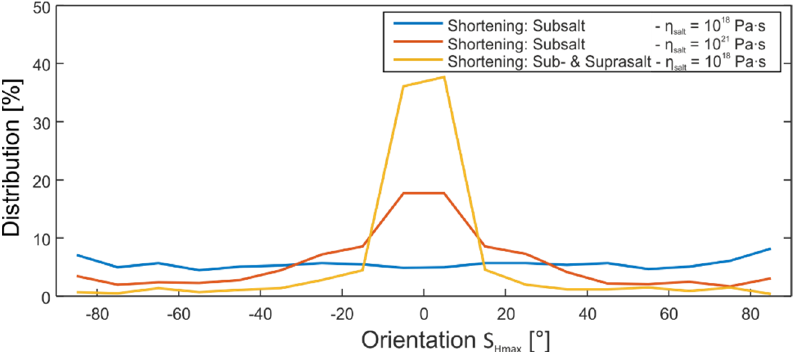
Figure 11 . Frequency distribution of S Hmax orientations at 3500 m depth for different viscosities (Models B-04c and B-07a) and in case of additional shortening in the suprasalt section by half the amount applied to the subsalt unit (Model B-02).